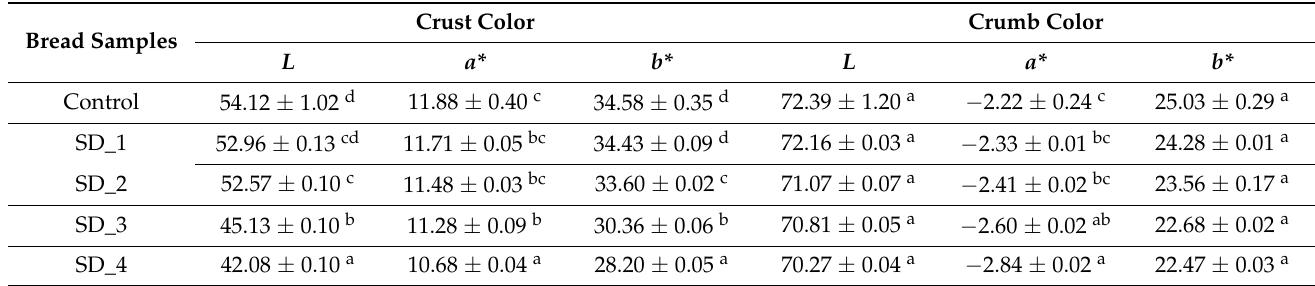
Table 6. Color measurements of bread samples with different levels of dry sourdough (SD) addition. Bread Samples